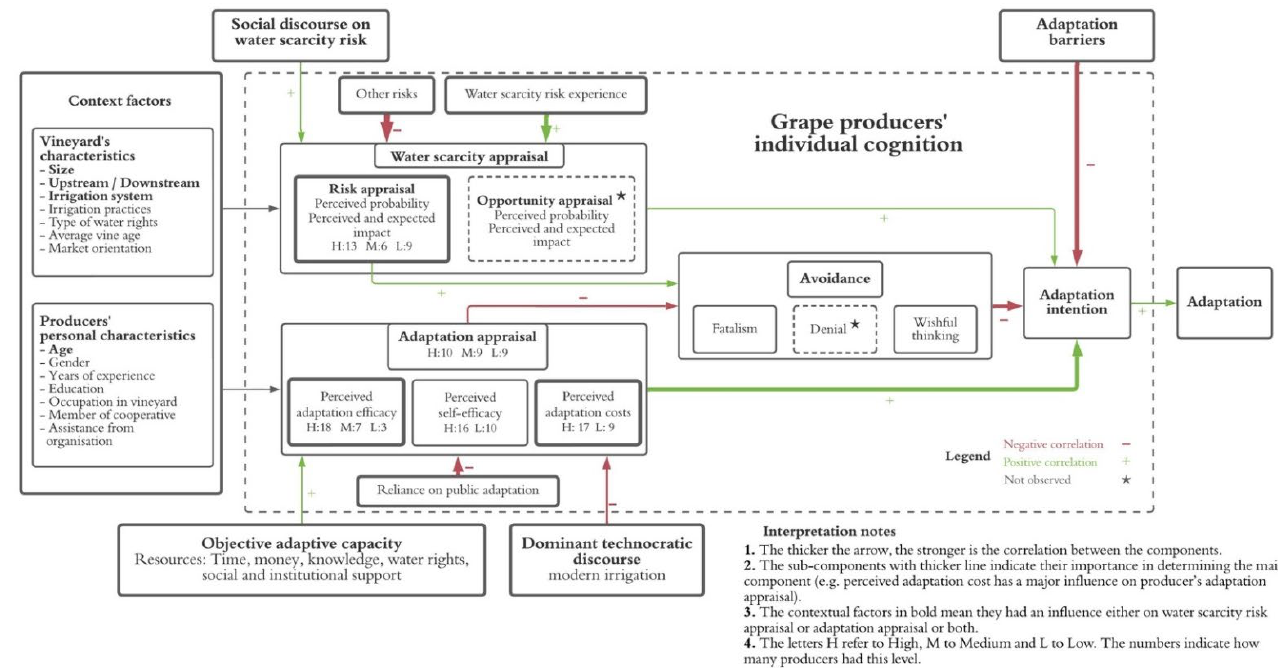
Figure 6. Summary of the research’s key findings using the GPAWS.